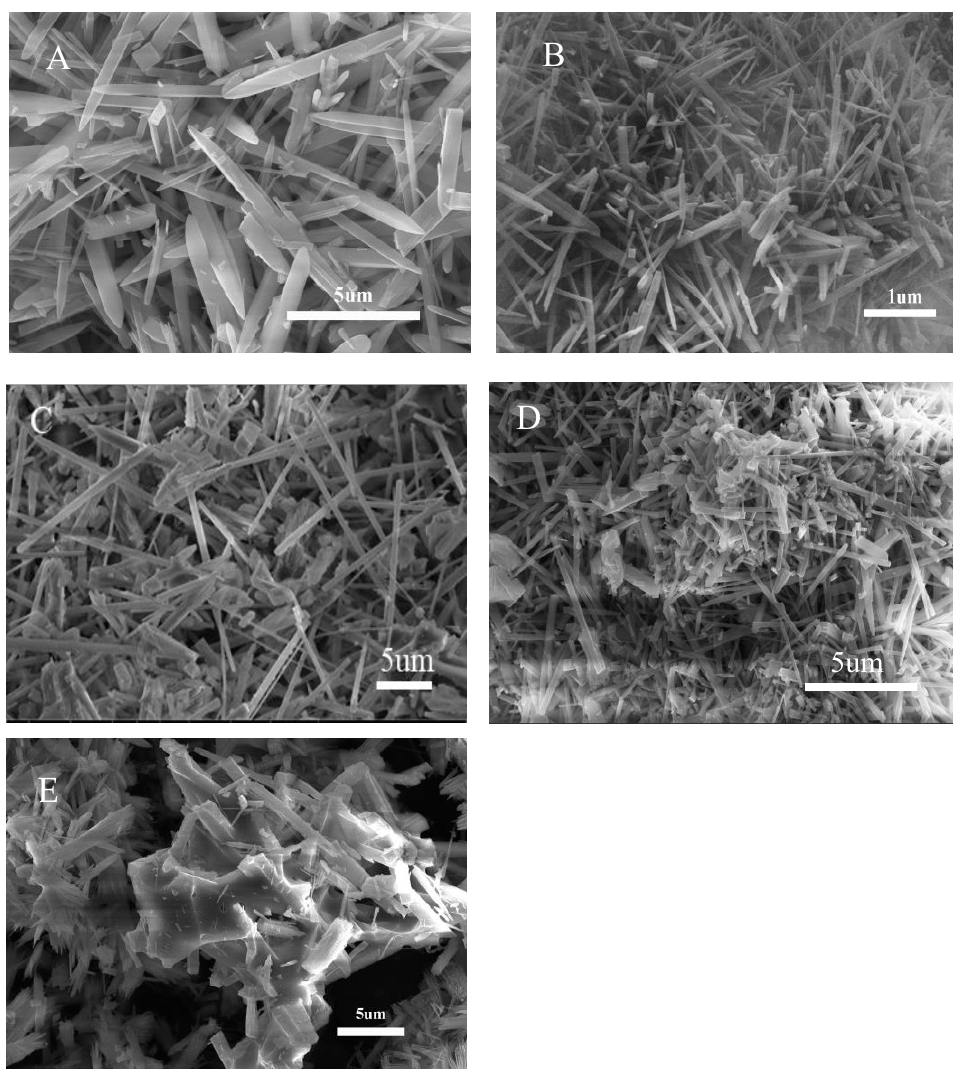
Figure 8. SEM images of mullite whiskers sintered at 700–750 °C. ( A1 ) 700 °C; ( A2 ) the EDS ele- mental analysis pattern of the corresponding point of A1 ; ( B1 ) 720 °C; ( B2 ) the EDS elemental anal- ysis pattern of the corresponding point of B1 ; ( C1 , C2 ) 750 °C.